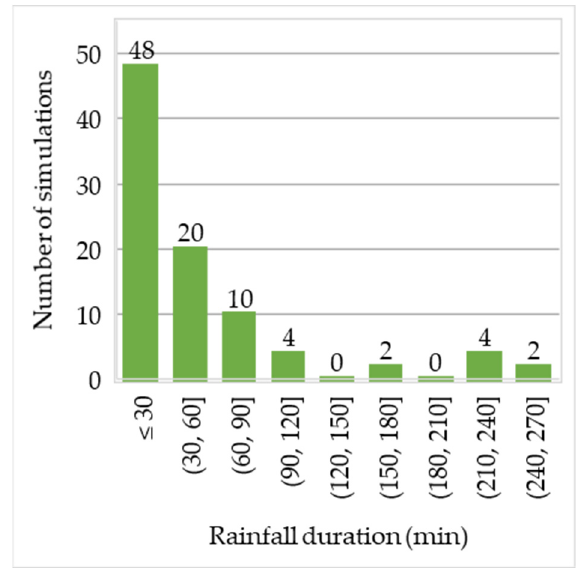
10 of 24 Figure 9. D 0 as a function of intensity for natural and simulated rainfalls. Note: two capital letters after reference represent the ISO Alpha-2 country code that designates countries in which measure- ments have been conducted [21,54,99–102,113,124–128]. Note: dotted lines represent simulated D 0 and rainfall intensity values that are given in a range. The duration of the simulated rainfall is determined by the availability of water nec- essary for the simulation and the intensity of the rainfall. If the water necessary for the